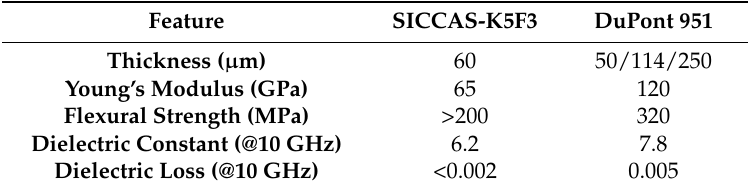
Table 2. The physical parameters of SICCAS-K5F3 and DuPont 951 LTCC materials.